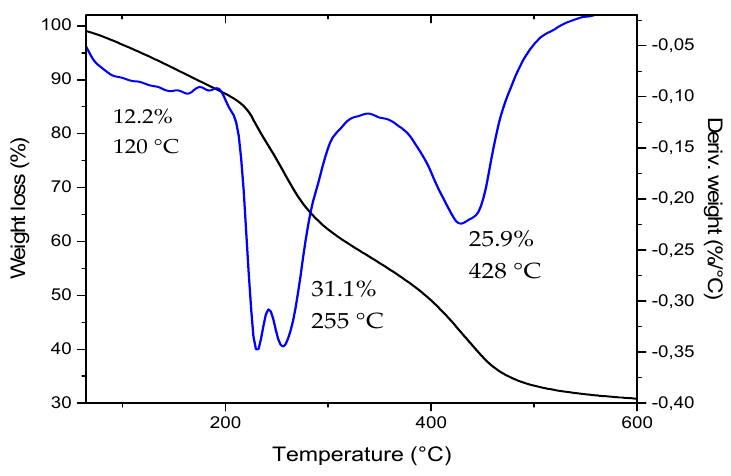
Figure 2. Thermogravimetric analysis of the CB.